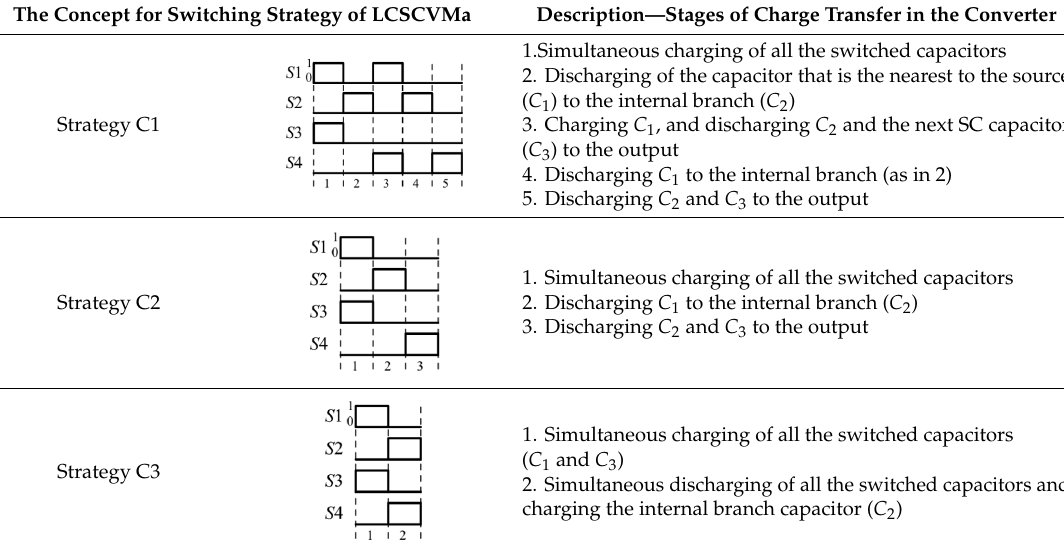
Table 1. Switching strategy concepts of the LCSCVMa. States of switches S 1 – S 4 .